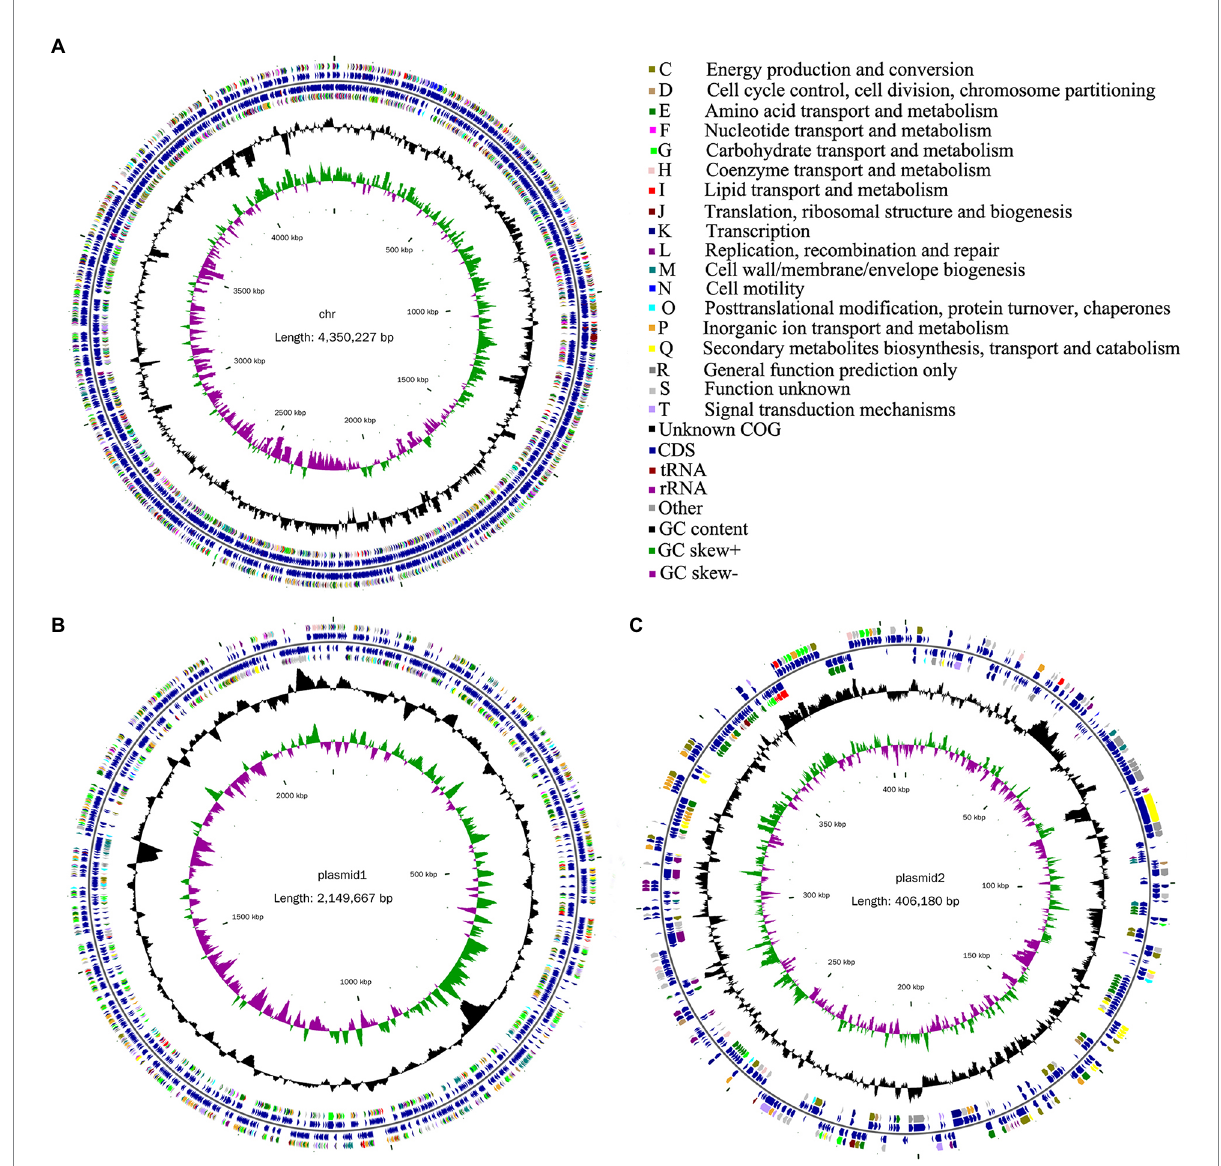
FIGURE 6 Circular representation of chromosome and plasmid of endophyte Rhizobium sp. WYJ-E13 strain isolated from the root of Curcuma wenyujin . (A–C) chromosome, plasmid1 and plasmid2, respectively; From the outer to the inner concentric circle: circle 1, genomic position in kilobases; circle 2, GC skew; circle 3, GC content; circle 4 and circle 7, the COG belonging to each CDS; circle 5 and circle 6, the position of CDS, tRNA and rRNA in the genome of strain WYJ-E13. Furthermore, C-T show the functional classification of the CDS genes in the chromosome and plasmid with the colors of the COG